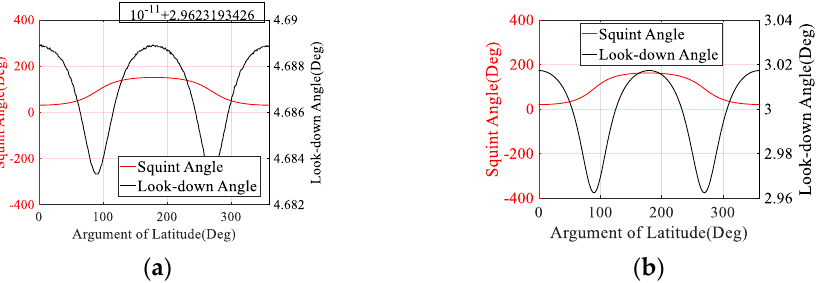
Figure 3. Squint and look-down angles along the orbit. ( a ) The eccentricity is 10 − 8 ; ( b ) The eccentricity is 0.01.